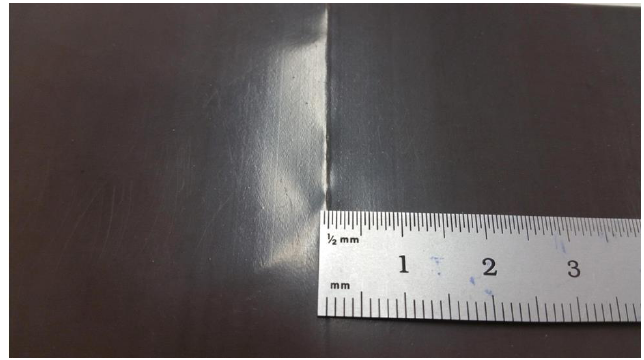
Figure 10. Representative photograph of a degraded two layer LLDPE polymer laser weld. Similar line width decrease is apparent in three layer LLDPE weld systems.